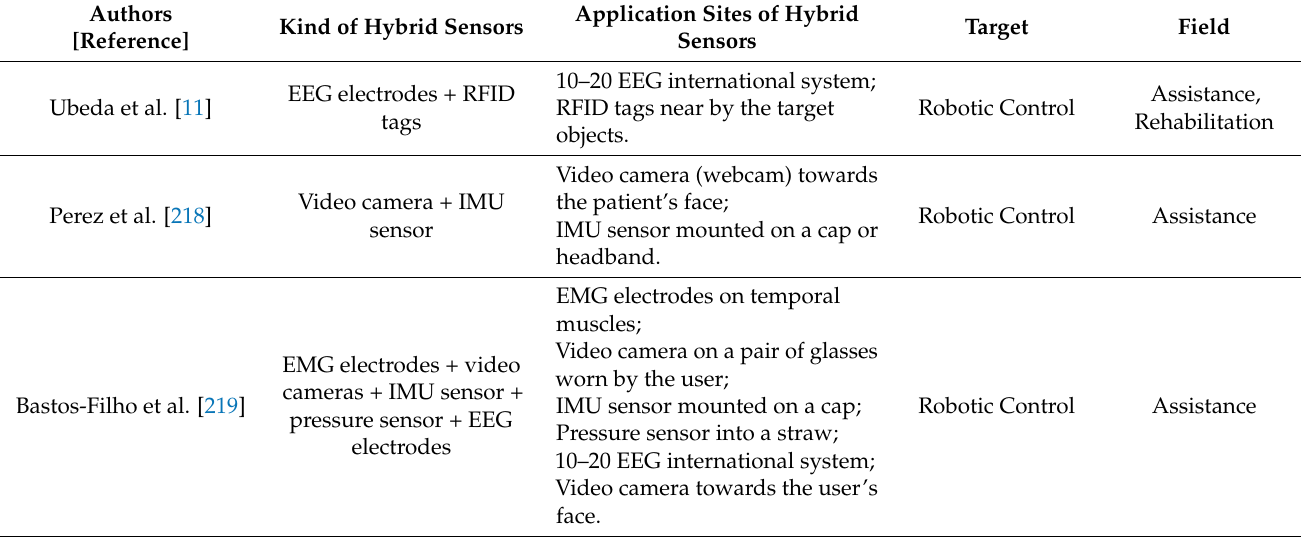
Table 15. Hybrid controls for HMIs based on various combinations of